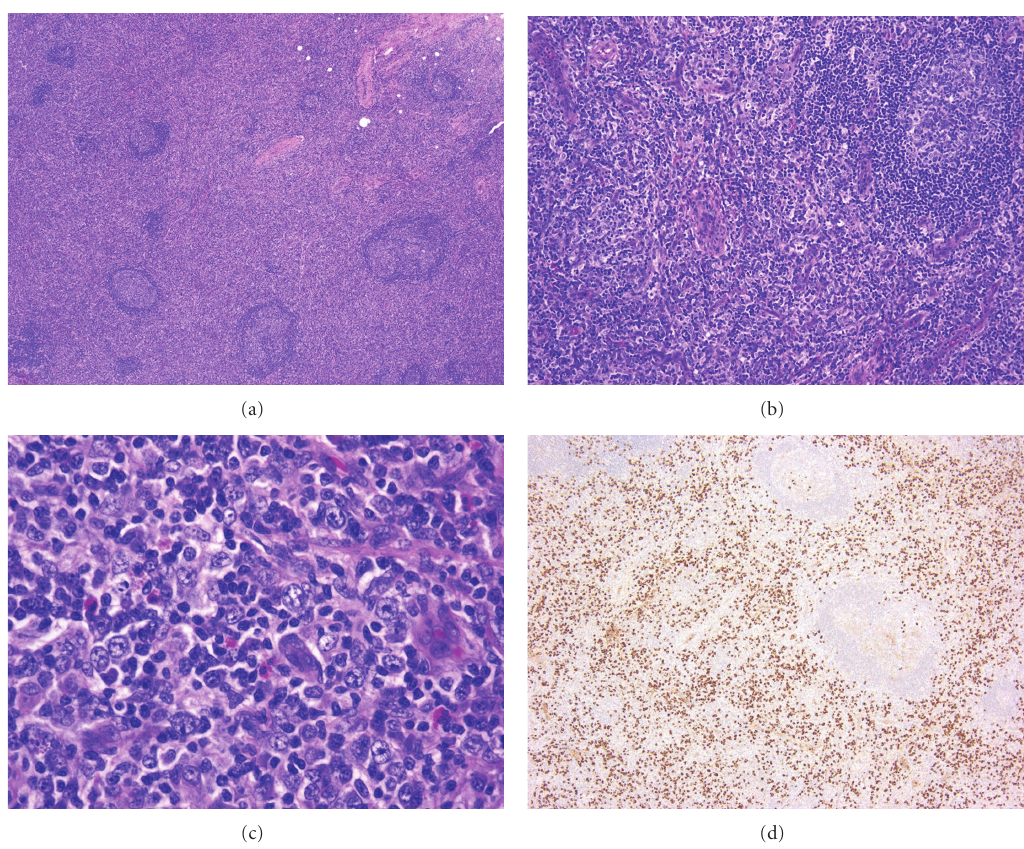
Figure 3: IgG4-related lymphadenopathy (type III). (a) The lymph node shows interfollicular expansion with normal to small germinal centers. (b) Hypervascular proliferation is seen in the interfollicular zone. (c) A mixed infiltrate of small lymphocytes, immunoblasts, immature plasma cells, mature plasma cells, and scattered eosinophils is observed (d) Numerous IgG4 + cells are present in the interfollicular